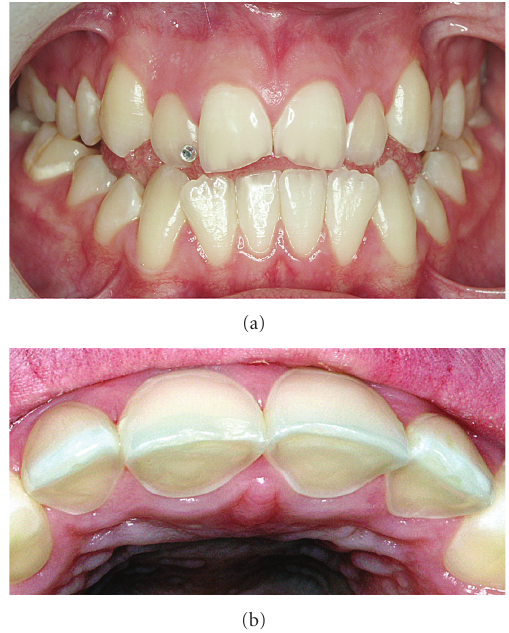
Figure 8: A 13-year-old girl who has a high intake of soft drinks. (a) Buccal erosion and crown shortening of the maxillary front teeth. Note the typical “inverted V-sign” often seen in cases of soft- drink-induced dental erosion. Mandibular incisors are relatively intact. (b) Severe erosive damage, with shoulder formation on the palatal surfaces of maxillary anterior teeth. Published with permission from the Journal of the Swedish Dental Association (Tandl¨akartidningen)